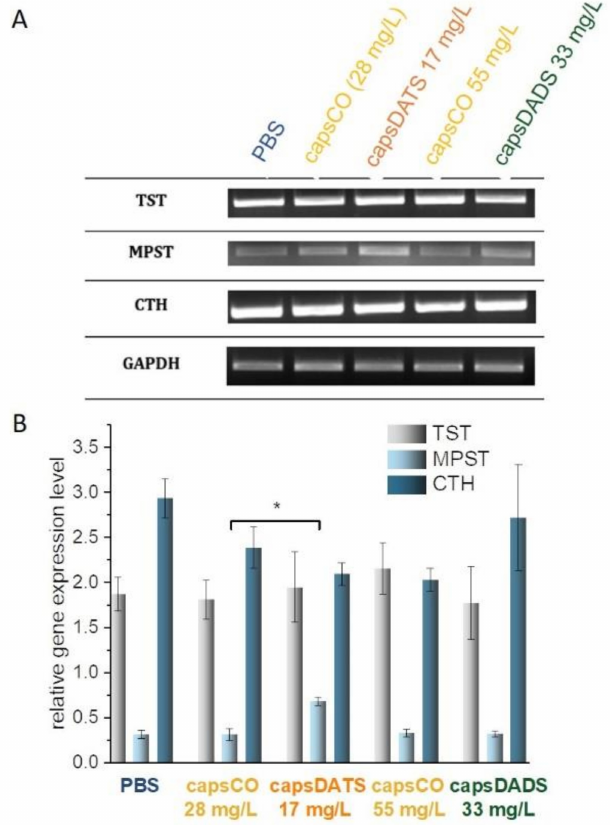
Figure 9. RT-PCR analysis of gene expression for TST, MPST and CTH. ( A ) Gene expression in the 4T1 cell line. The results are representative and obtained from 3 tests. ( B ) The relative gene expression level of TST, MPST and CTH in 4T1 cell line, presented as means +/ − SD (n = 3). The densities of bands were normalized using the signal for the reference GAPDH gene. Significance estimated with the Mann–Whitney U-test in relation to the respective control groups (samples treated with PBS); * p <